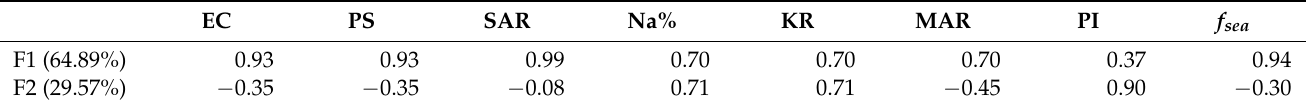
Table 2. Factor loading of the principal component analysis.